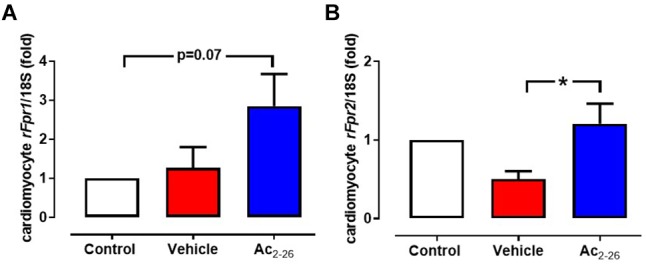
Ac2-26 increases cardiomyocyte expression of rFprs. Ac2-26 tends to increase expression of (A)
rFPR1 and (B) significantly increases rFPR2 expression. ∗P < 0.05 versus paired vehicle-treated mice, one-way repeated measures ANOVA with Dunnett’s post hoc test. n (number of different cardiomyocyte preparations) = 5. Data were presented as mean ± SEM.